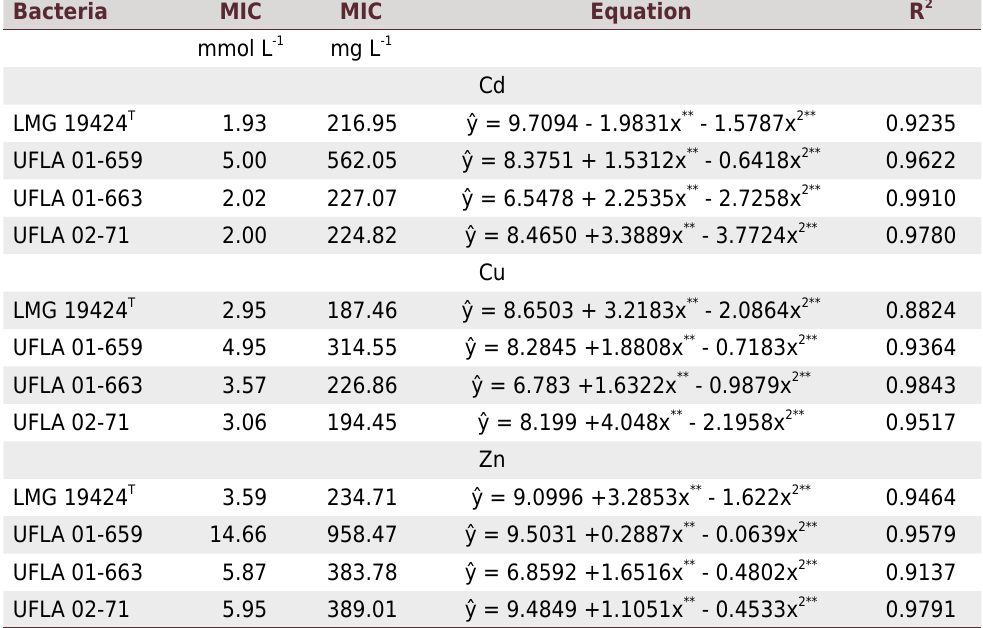
Table 1. Minimum inhibitory concentration (MIC) of Cd, Cu, and Zn for the growth of different bacterial strains of the genus Cupriavidus spp. in liquid LB culture medium, calculated by quadratic equations